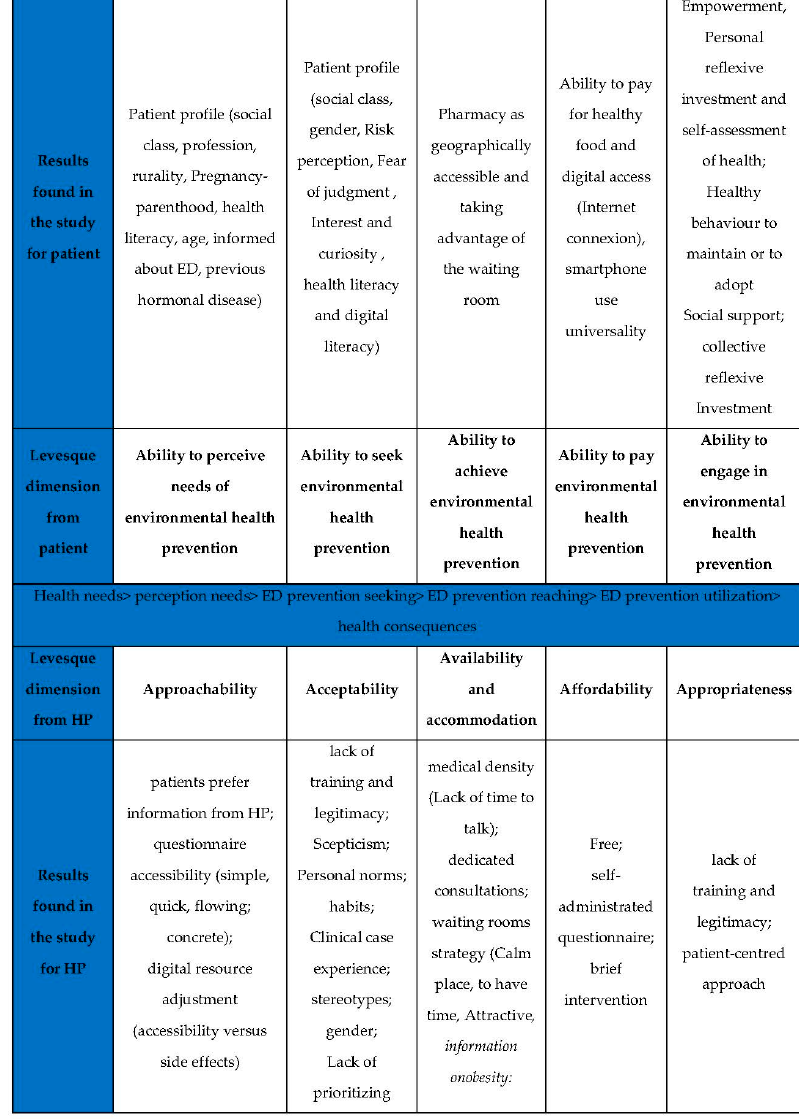
Figure 2. Results implemented in Levesque model.